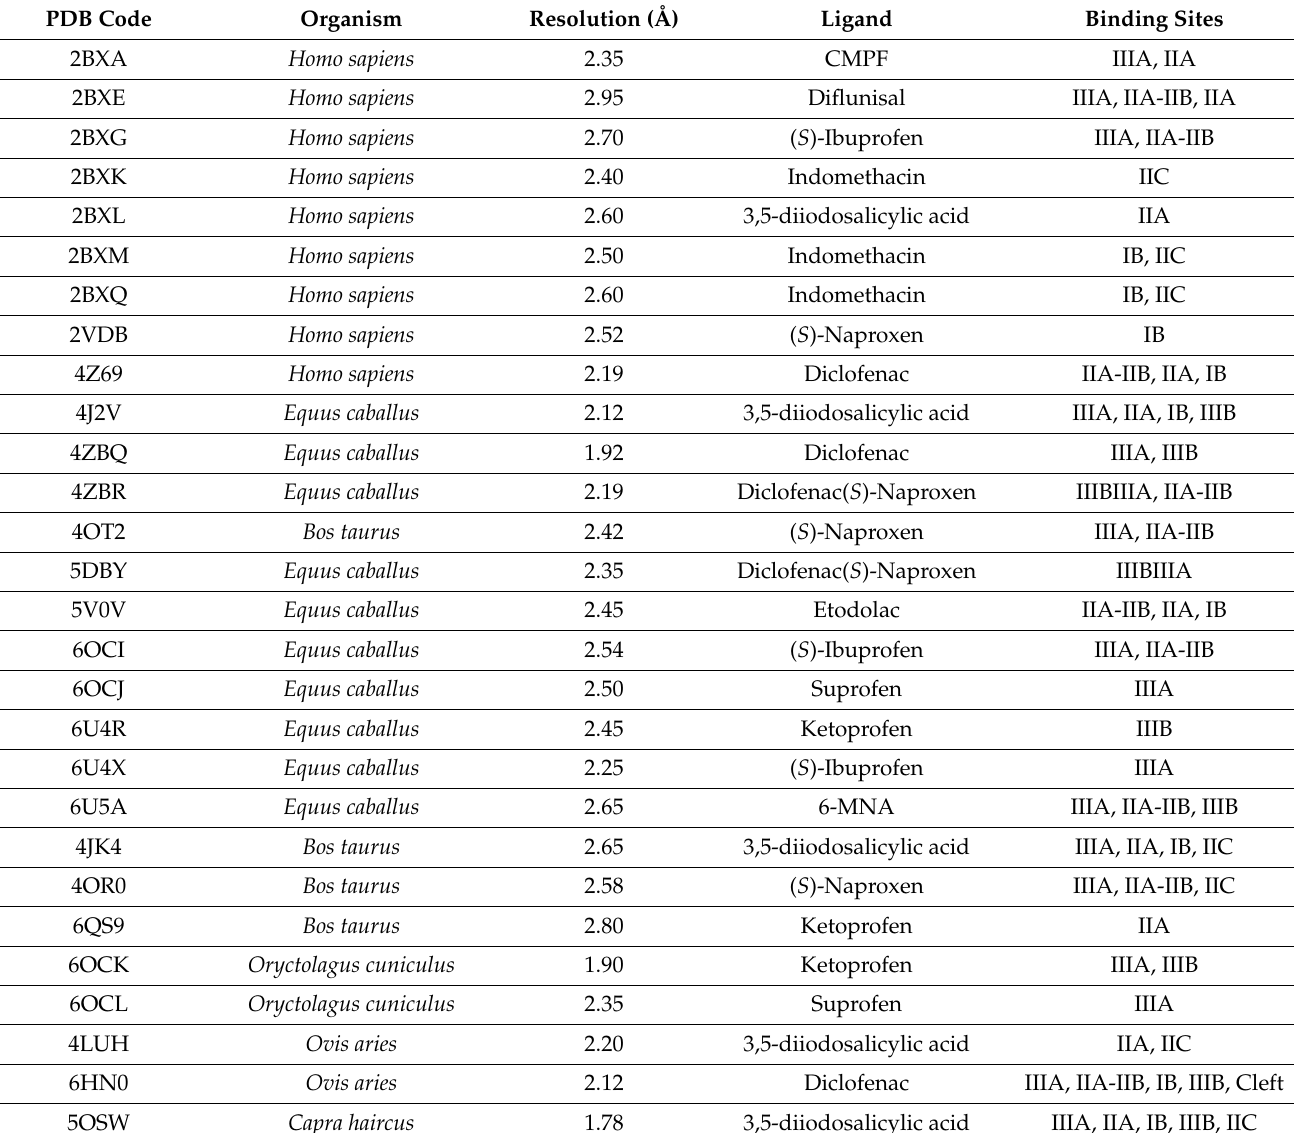
Table 6. X-ray crystallographic structures included in the structural analysis of albumin complexed with ibuprofen, naproxen, diflunisal, and NSAID-related